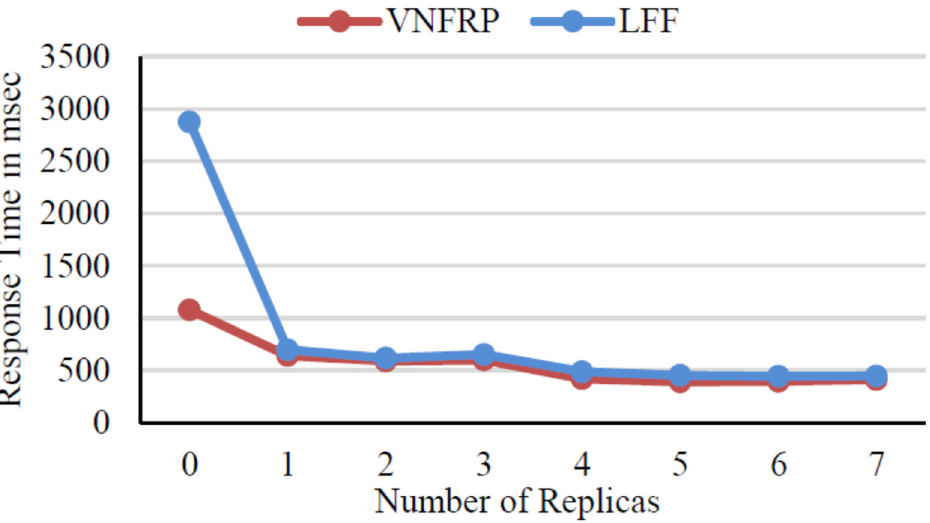
Figure 7. Service response time when adopting the VNFRP algorithm and the corresponding values when adopting the LFF strategy.